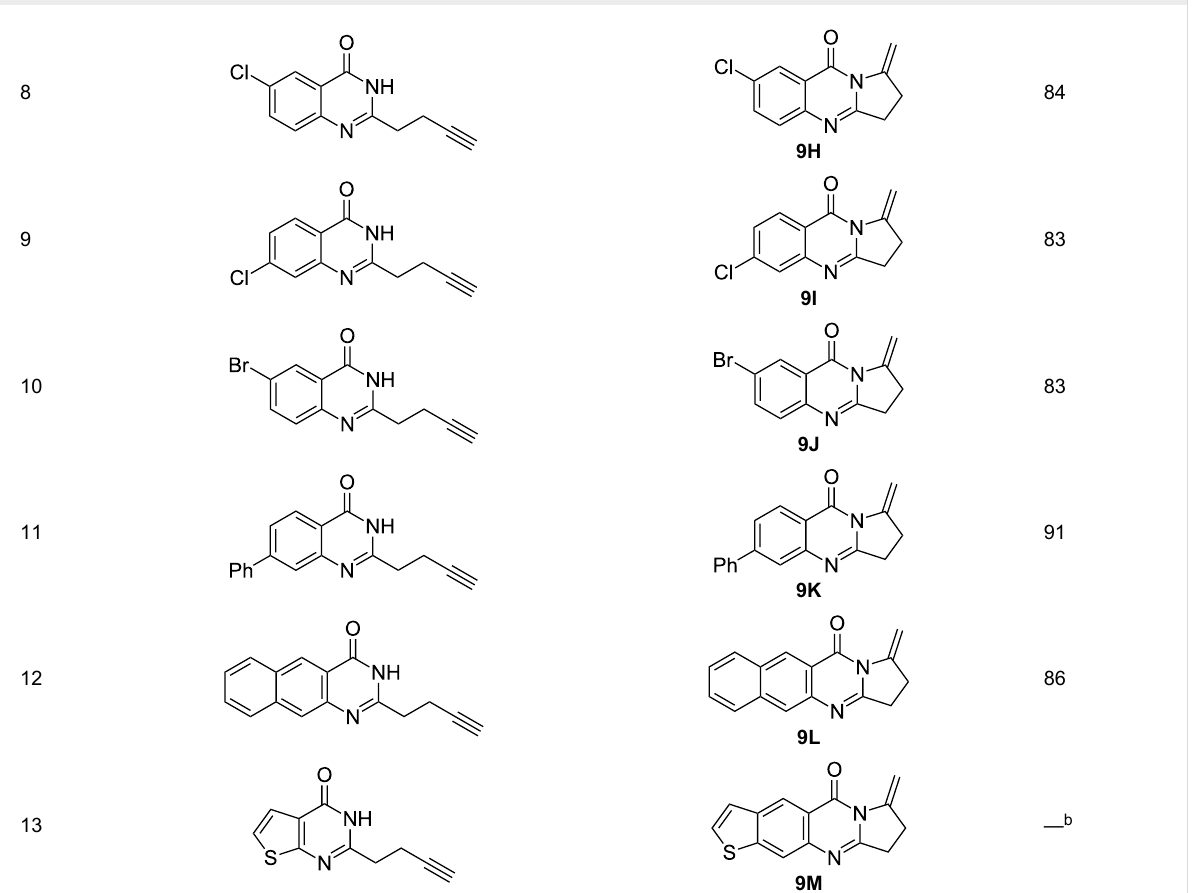
Table 3: Silver-mediated synthesis of target compounds 9A–L . a